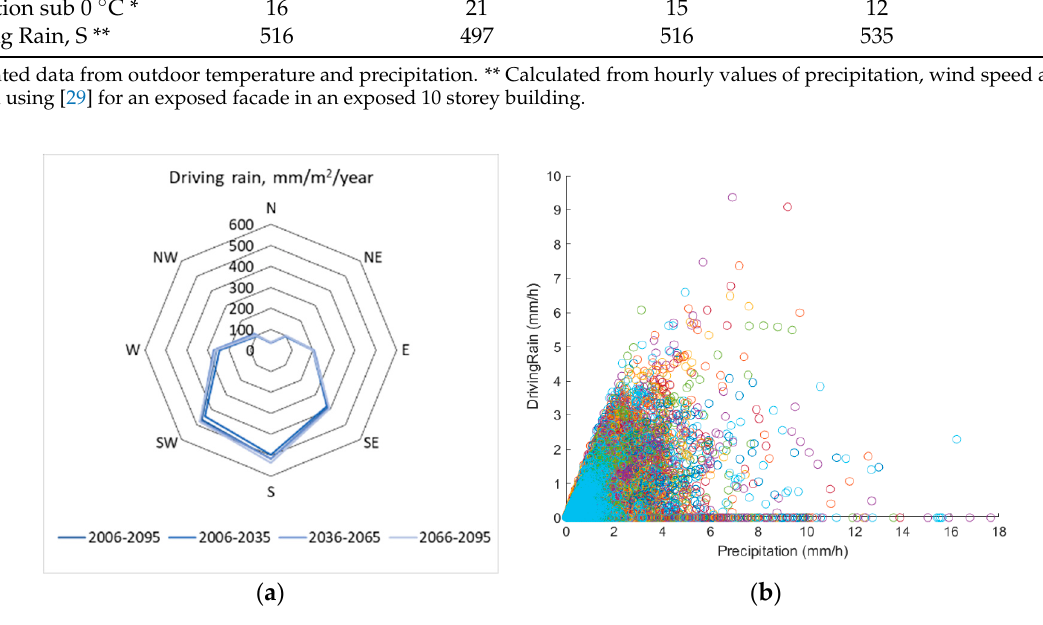
Figure 6. Driving rain on different facades of the building: ( a ) calculated data for driving rain on a facade in eight different directions (mm/m 2 /year); ( b ) driving rain on the south facing facade of the building plotted against horizontal precipitation (mm/h). Hourly data year 2006–2095.